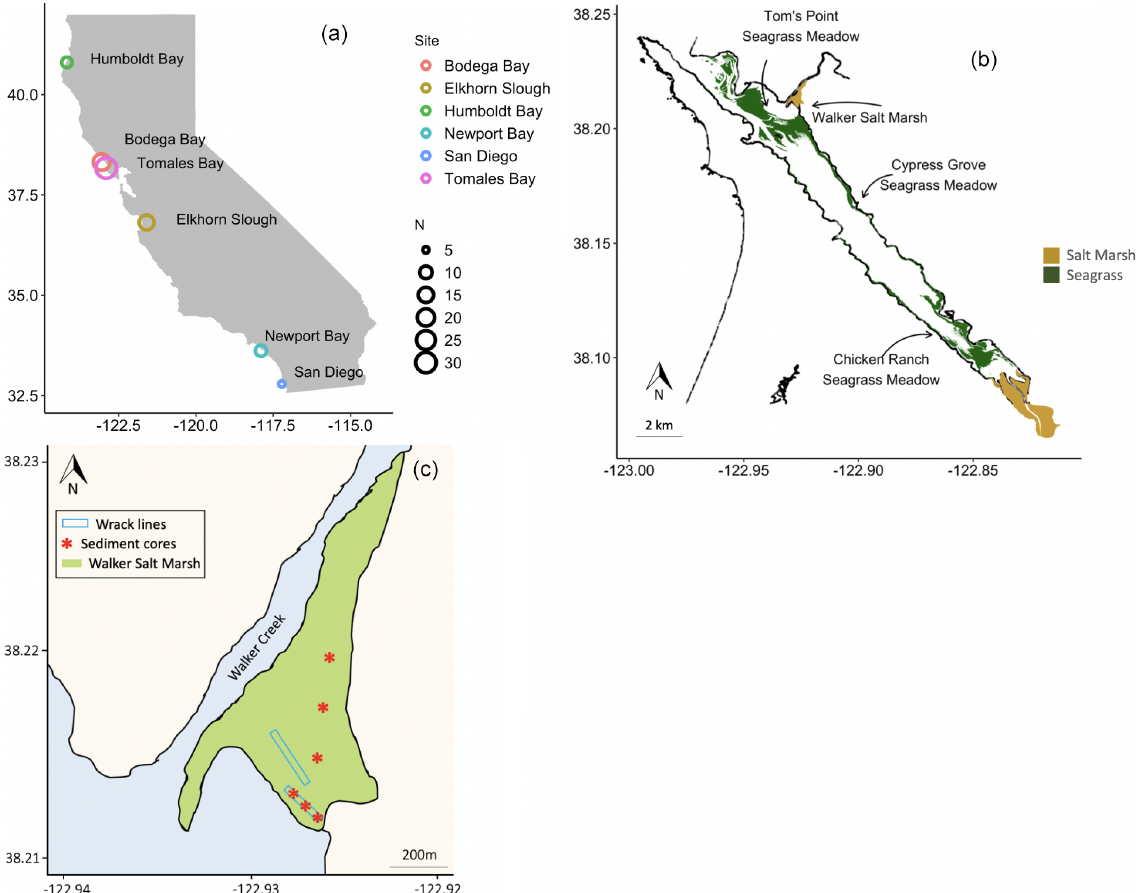
Figure 1. Sediment cores were collected from six estuaries across a latitudinal gradient in California, where N = number of cores (a) . Seagrass wrack deposition into Walker Salt Marsh from surrounding seagrass meadows (Merkel and Associates, 2017) was estimated, while sediment cores were taken from all four labeled habitats (b) . Three sediment cores were collected beneath persistent wrack lines in Walker Salt Marsh, while three were collected from areas that do not receive regular, annual tidal deposition of wrack (c)